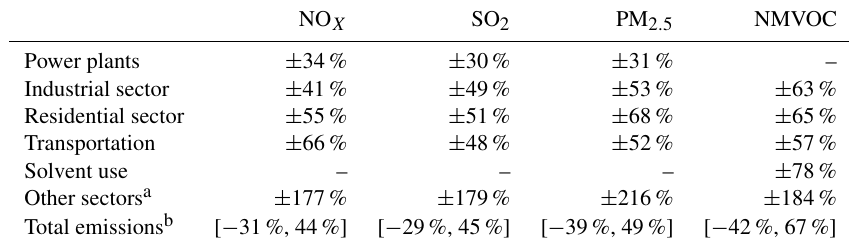
Table 6. Results of the uncertainty analysis of the emissions in China.